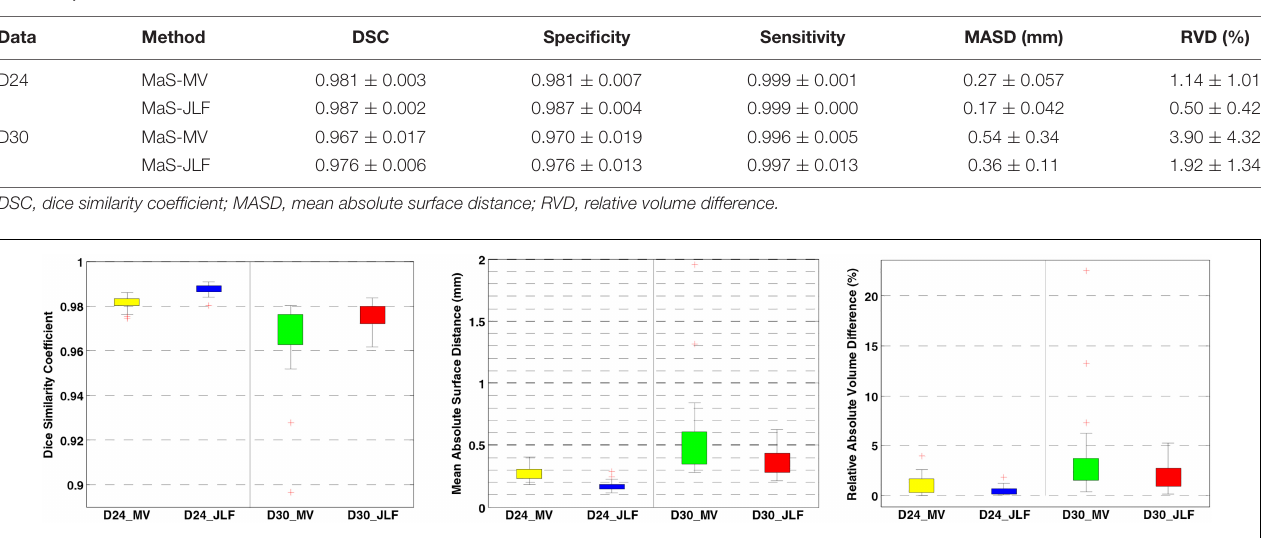
TABLE 1 | Quantitative evaluation of the tested methods on the two datasets.